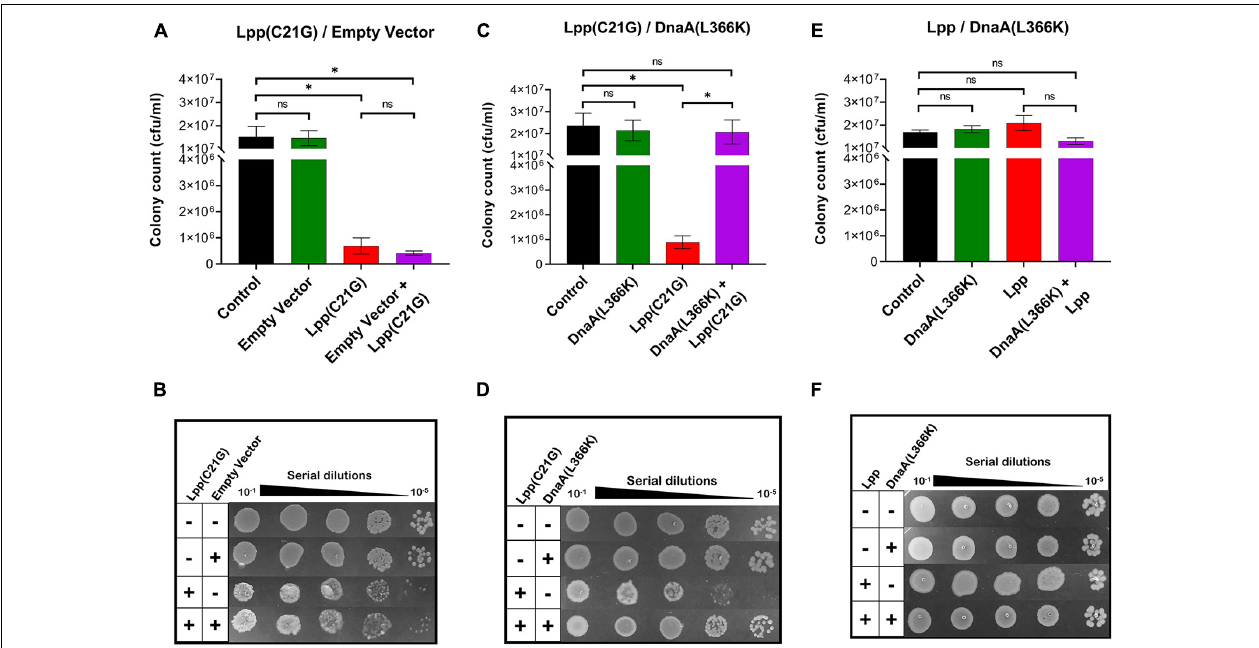
FIGURE 1 | DnaA(L366K) overexpression rescues growth in cells expressing Lpp(C21G). (A) Viability of lpp-null cells transformed with empty vector, and plasmids expressing Lpp(C21G). No inducer control (black), in the presence of 0.2% Arabinose (green) for empty vector, 50 µ M IPTG (red) for Lpp(C21G), and 50 µ M IPTG + 0.2% Arabinose (purple) for both Lpp(C21G) and empty vector expression in M9+CAA+Glu media. (B) Serial dilutions of lpp-null cells, capable of expressing plasmid-derived Lpp(C21G) and empty vector, on agar plates. (C) Viability of lpp-null cells expressing DnaA(L366K) and Lpp(C21G). No inducer control (black), in the presence of 0.2% Arabinose (green) for DnaA(L366K), 50 µ M IPTG (red) for Lpp(C21G), and 50 µ M IPTG + 0.2% Arabinose (purple) for both Lpp(C21G) and DnaA(L366K) expression in M9+CAA+Glu media. (D) Serial dilutions of lpp-null cells, capable of expressing plasmid-derived Lpp(C21G) and DnaA(L366K), on agar plates. (E) Viability of lpp-null cells expressing DnaA(L366K) and Lpp. No inducer control (black), in the presence of 0.2% Arabinose (green) for DnaA(L366K), 50 µ M IPTG (red) for Lpp, and 50 µ M IPTG + 0.2% Arabinose (purple) for both Lpp and DnaA(L366K) expression in M9+CAA+Glu media. (F) Serial dilutions of lpp-null cells, capable of expressing plasmid-derived Lpp and DnaA(L366K), on agar plates. Viability is expressed in cfu/ml and presented on a linear scale. Data are means ± SEM of at least three independent experiments. ∗ p < 0.05, ns p > 0.05 in one-way ANOVA with Dunnett’s multiple comparison